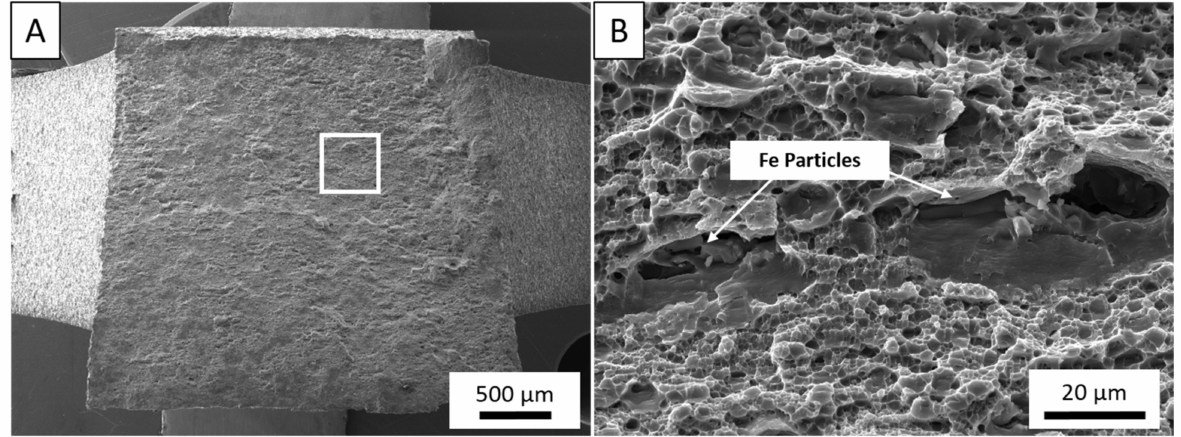
Figure 7. ( A ). Low magnification overview of 45 ◦ fracture of a AA5083-H131 control sample. ( B ) Large voids, surrounded by microvoids, coalesced from fractured iron particles along rolling